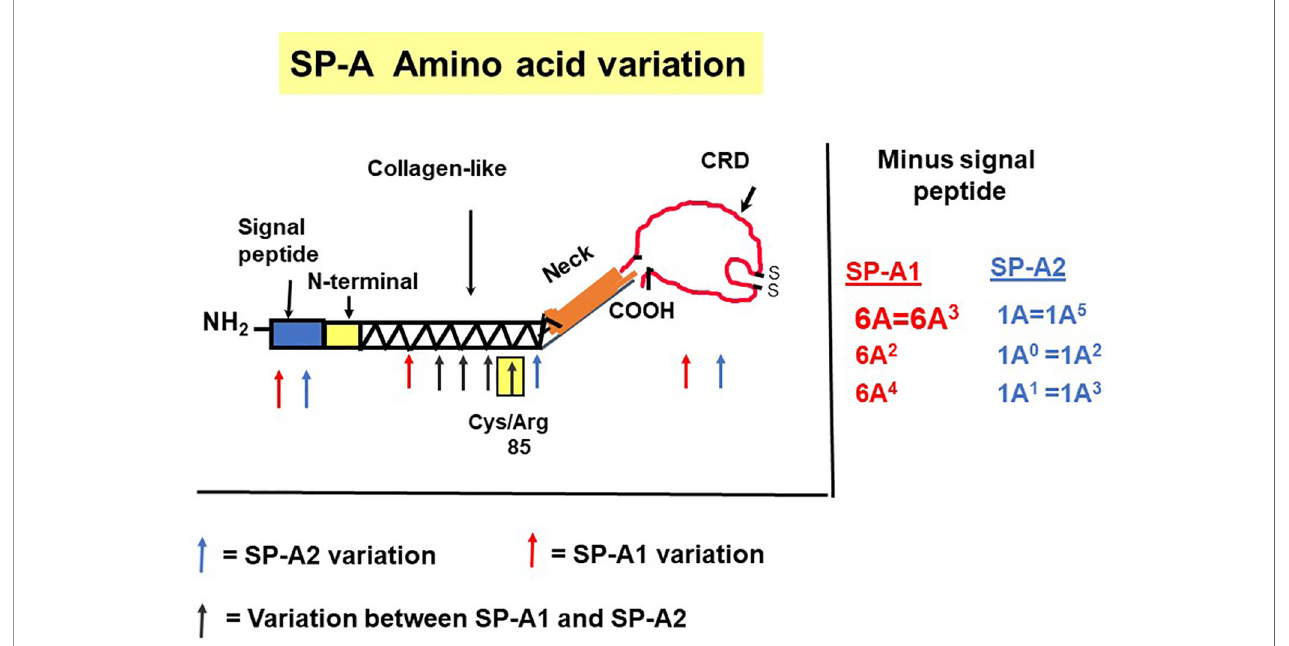
FIGURE 4 | SP-A regions encoding the precursor molecule and the location of the gene-speci fi c and variant-speci fi c amino acid differences is shown (27). The numbering of the amino acids is that of the precursor molecule (i.e., includes the signal peptide). The notation of the most frequently observed variants for each gene is shown on the right. Some of the variants are identical after cleavage of the signal peptide